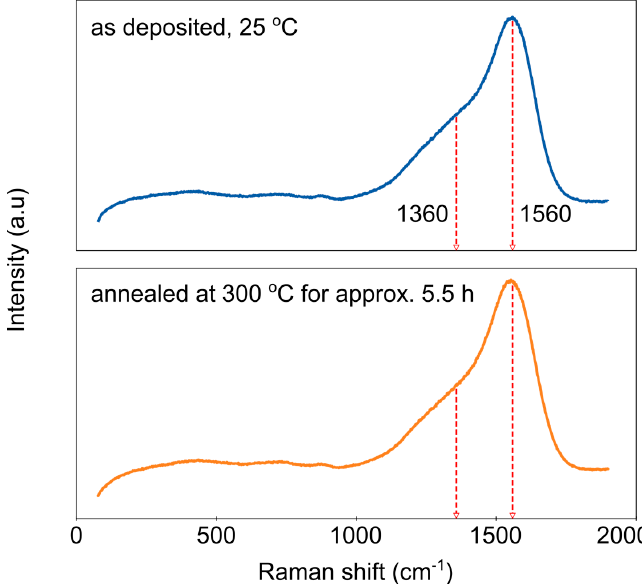
Figure 10. Raman spectra of the applied DLC coating, as-deposited and annealed at 300 ° C.